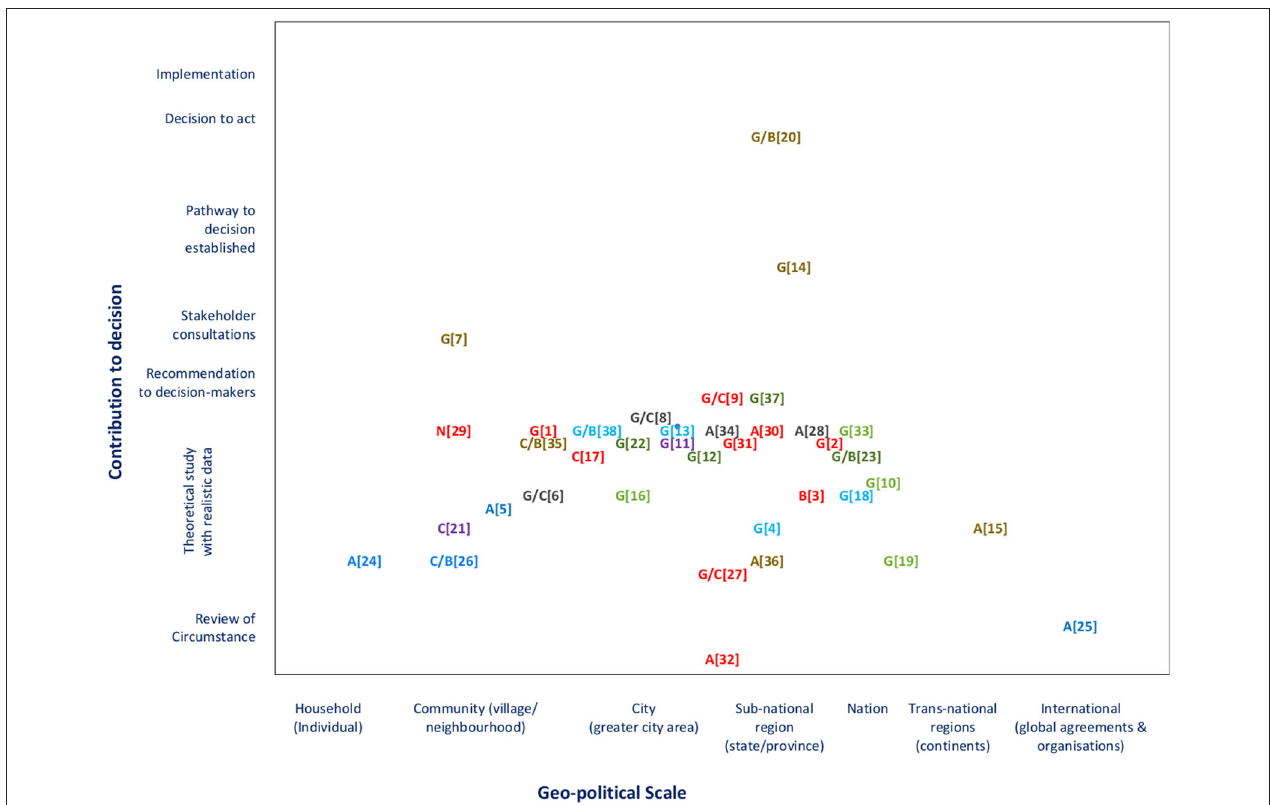
FIGURE 7 | A graphic relating case studies to (i) Geopolitical scale of a decision (ii) the commitment to the result of the case study, (iii) the decision-making bodies concerned and (iv) the decision analytic approach used. Symbols represent three components. Colour is the decision analytic approach: red, Bayesian; brown, Decision-Making under Deep Uncertainty; dark blue, Decision Process Management; purple, Economic and Financial Methods; light blue, Interval Methods; light green, full ranking MCDA; dark green, partial ranking MCDA; black, Soft Elicitation. Letters are decision-making bodies: C, Community; G, Government; B, Business/Industry; F, Finance; N, NGO; A, All categories. Numbers in square brackets are the citation: [1] Åström et al. (2014); [2] Alexeeff et al. (2016); [3] Baker and Solak (2011); [4] Batisha (2015); [5] Biehl et al. (2017); [6] Bosomworth et al. (2017); [7] Brown et al. (2019); [8] Butler et al. (2016); [9] Catenacci and Giupponi (2013); [10] de Bruin et al. (2009); [11] de Ruig et al. (2019); [12] El-Zein and Tonmoy (2015); [13] Gilbuena et al. (2013); [14] Groves et al. (2019); [15] Hall et al. (2012); [16] Haque (2016); [17] Jäger et al. (2018); [18] Kim and Chung (2013); [19] Konidari and Mavrakis (2007); [20] Lempert and Groves (2010); [21] Manocha and